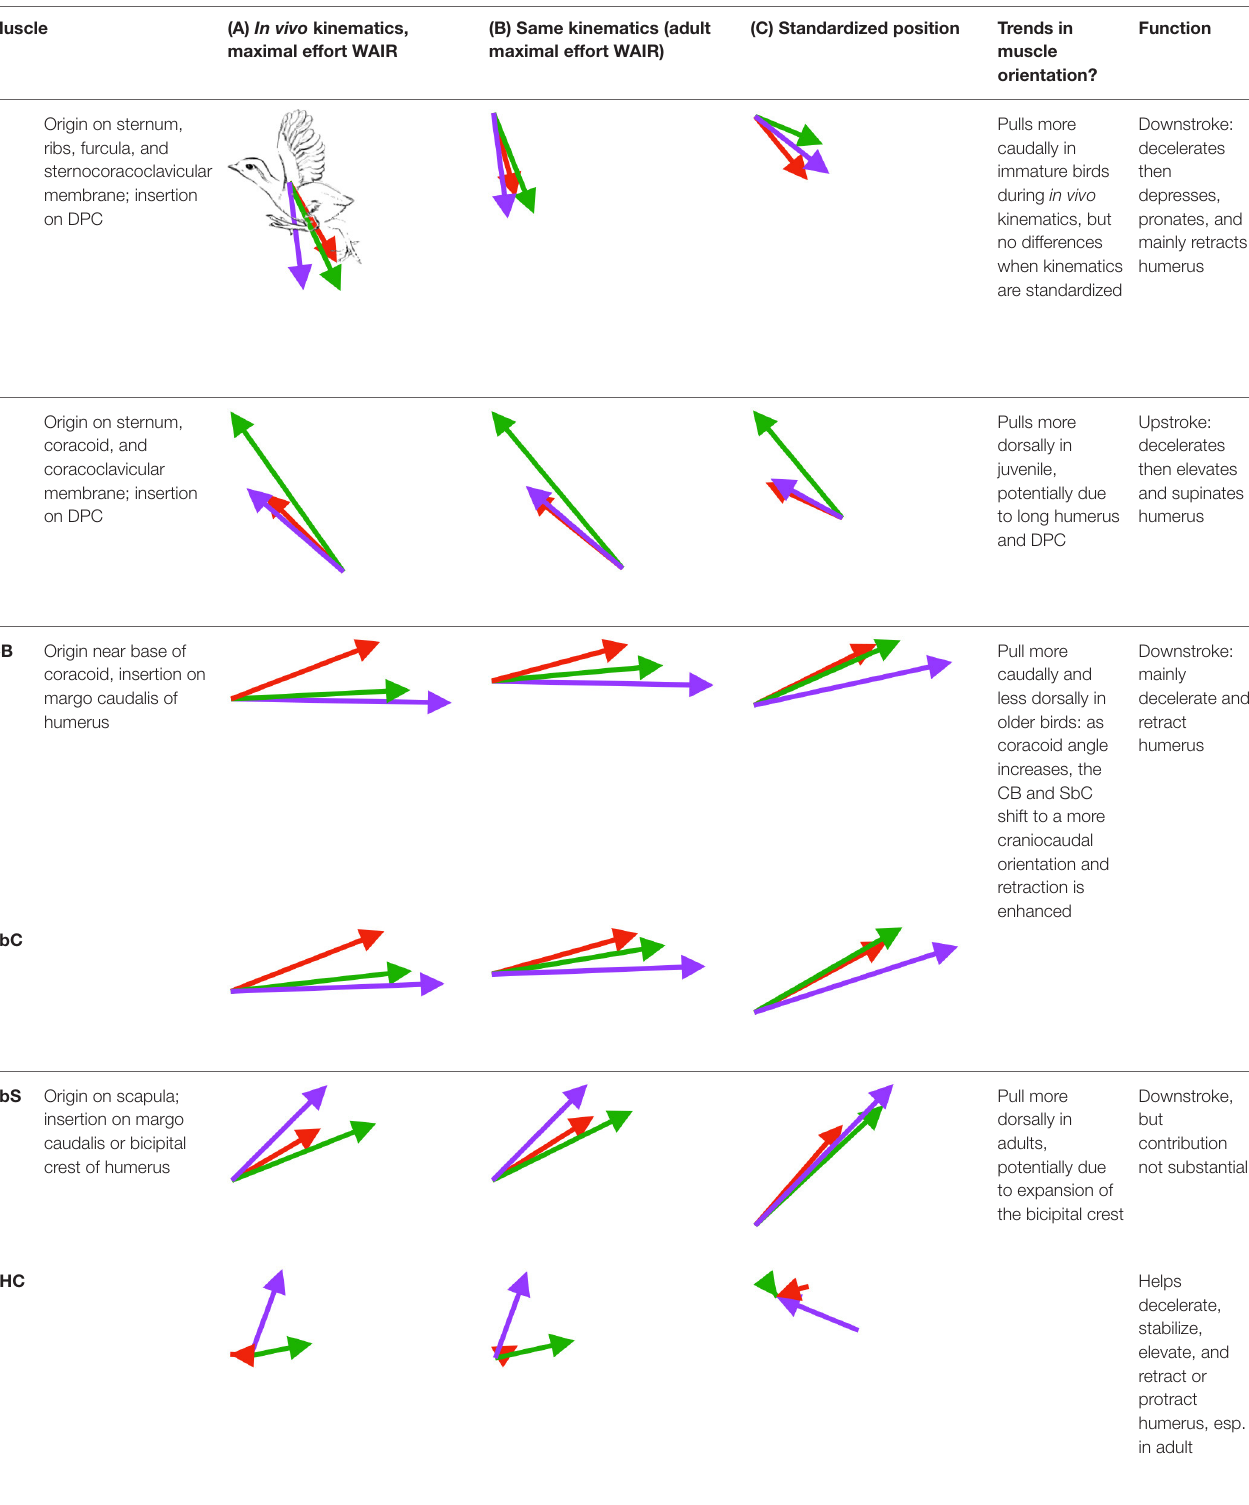
TABLE 1 | Muscle orientations and pull.